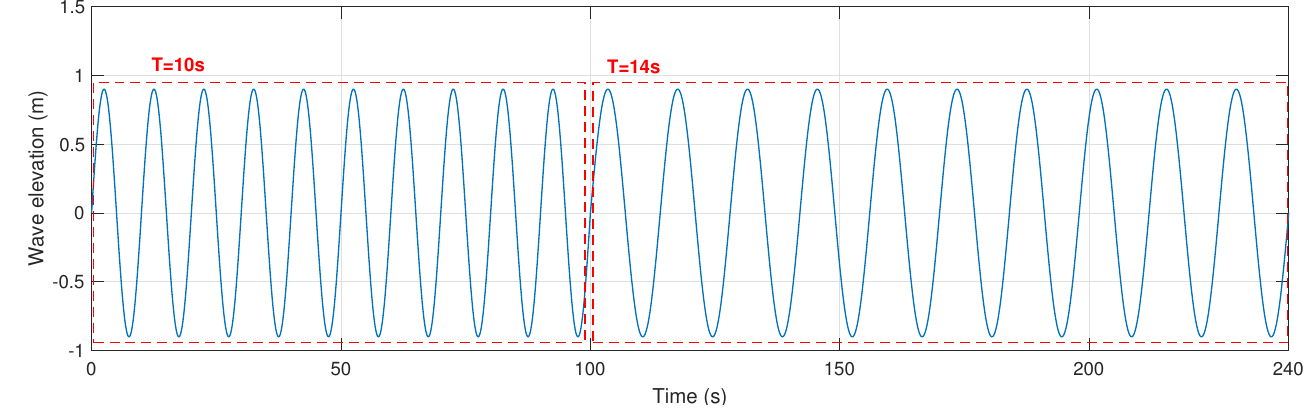
Figure 7. Considered wave input to the barge-based